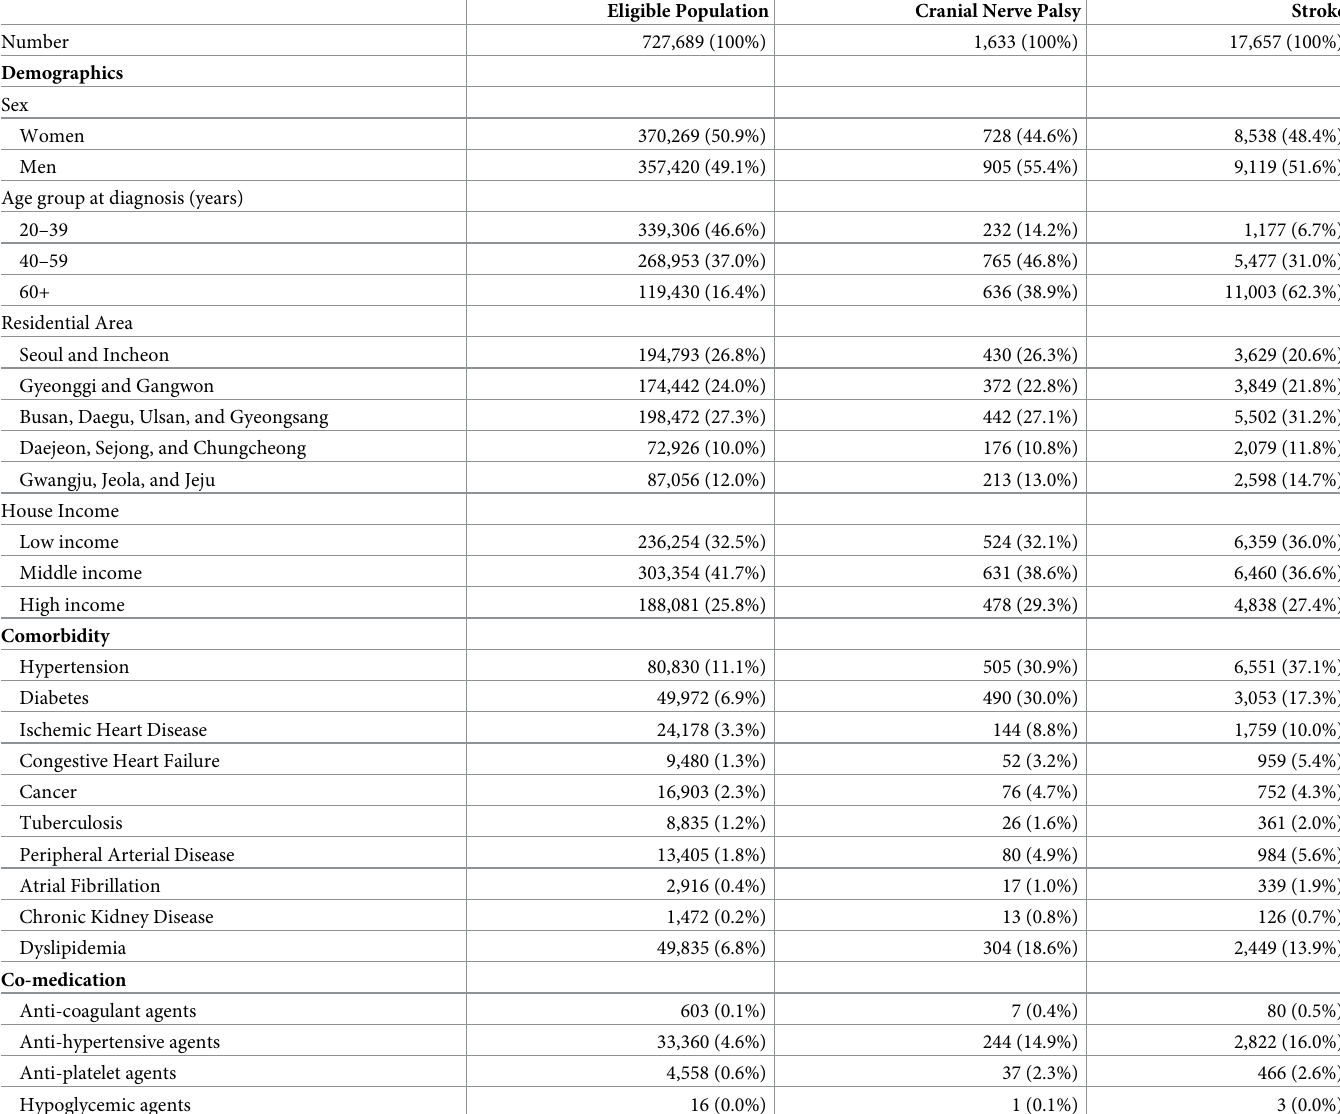
Table 1. Demographics and characteristics of eligible population included in the analysis and those with incident cranial nerve palsy and incident